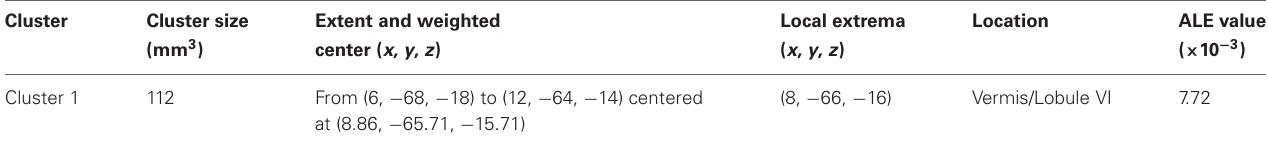
Table 3 | Overlap of regions engaged during the early and late phases of explicit sequence learning. Cluster Cluster size Extent and weighted Local extrema